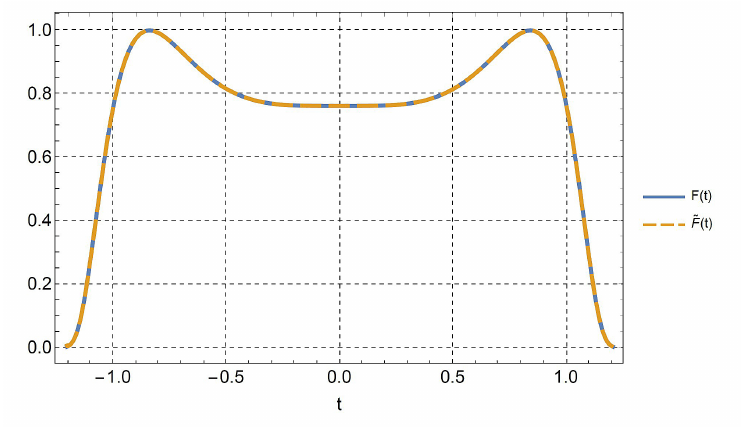
Figure 15. Graph of the function F ( t ) = exp [ − ( sinh ( t 4 − 1/2 )) 2 . The percentage deviation between F ( t ) and the relevant expansion ˜ F ( t ) in terms of Bell’s polynomials is shown in Figure 16. As can be seen, F ( t ) is nicely approximated by ˜ F ( t ) in the domain where F ( t ) does not assume negligibly small values.